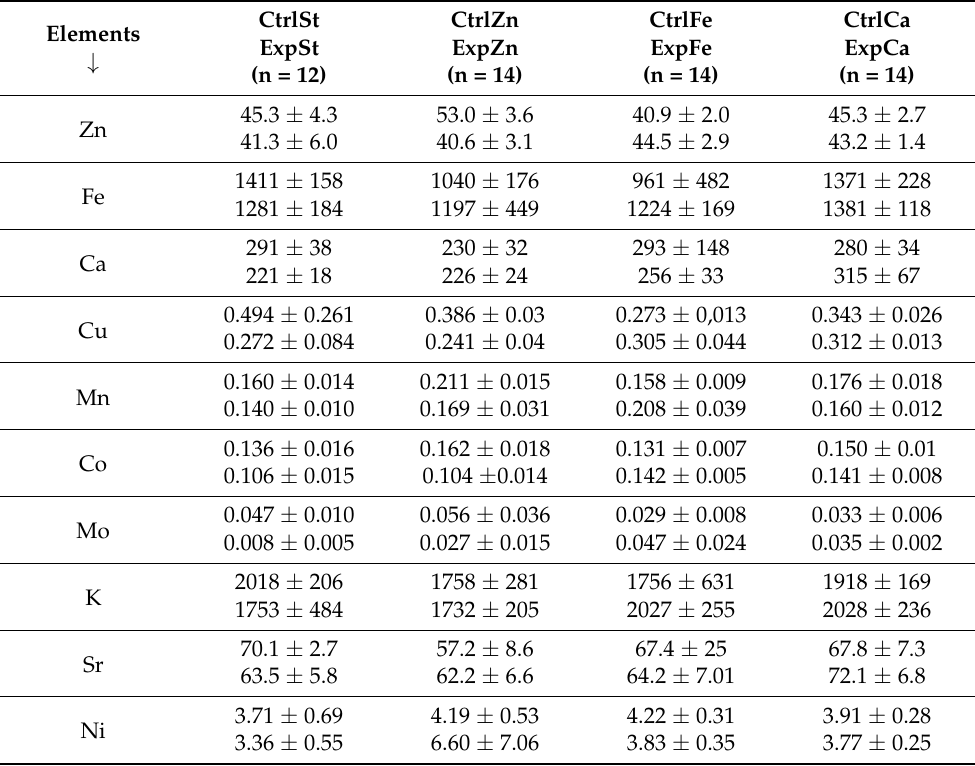
Table 5. Mean values ± standard deviation of the elemental content (mg/kg, dry mass of bone) in controls and experimental groups of rats (content of